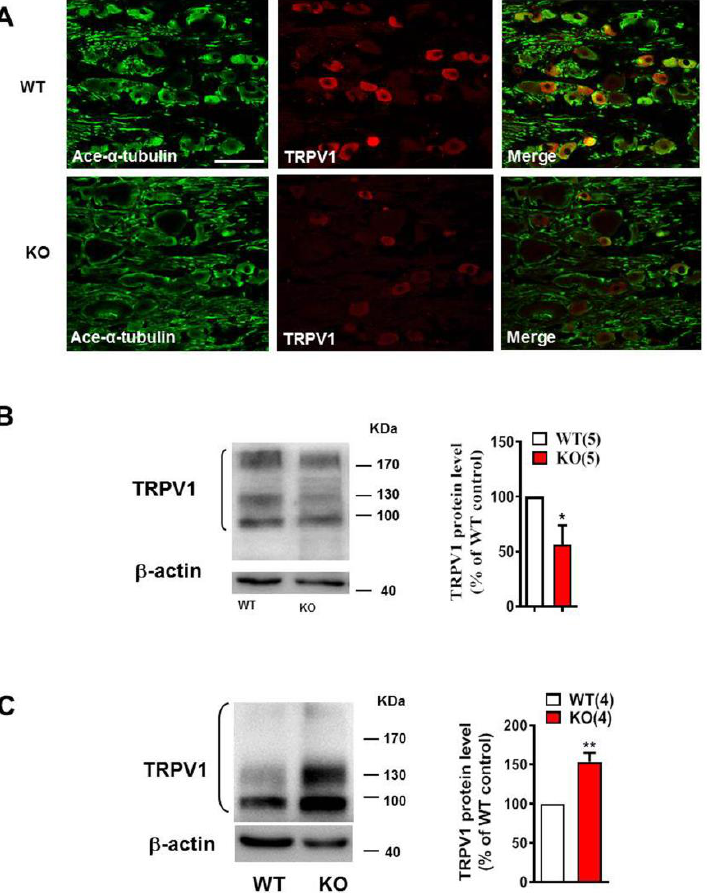
Figure 4. KO of Nogo-A decreased the co-localization of TRPV1 with ace- α -tubulin in the CFA- induced inflammatory pain. ( A ) The co-location of ace- α -tubulin and TRPV1 was decreased in the DRG neurons of Nogo-A KO with CFA injection. ( B ) The total TRPV1 (the monomer, glycosylation, and polymerization of TRPV-1) were included for the quantification and it was significantly decreased in DRG of Nogo-A KO rat with CFA injection, compared with that of the WT rat (* p < 0.05, unpaired t -test, n = 5). ( C ) The total TRPV1 was significantly higher in Nogo-A KO rat with CFA injection than that of WT after intrathecal injection of 10 µ g paclitaxel, indicating that increase of the polymerization microtubule with paclitaxel could compensate the TRPV1 decrease resulted from the disassembly of microtubule due to KO of Nogo-A (** p < 0.01, unpaired t -test, n = 4). The scale bar in ( A ) is 100 µ